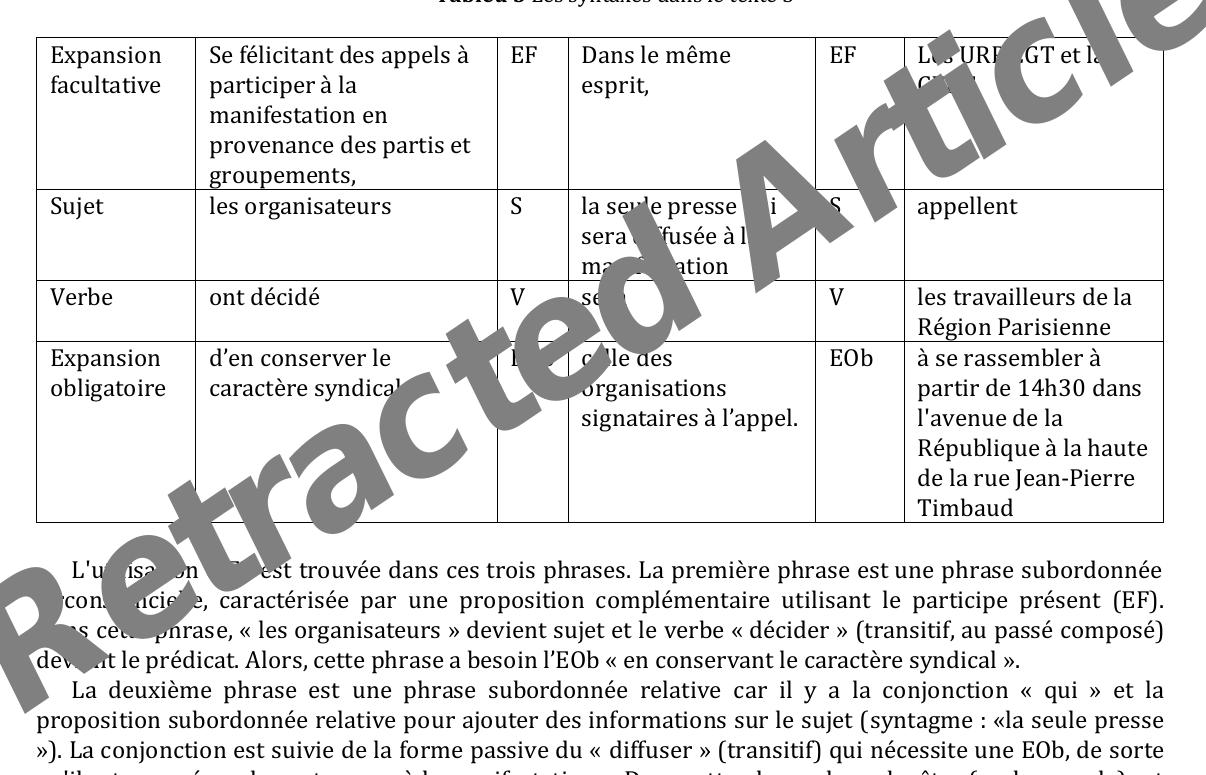
Tableu 5 Les syntaxes dans le texte